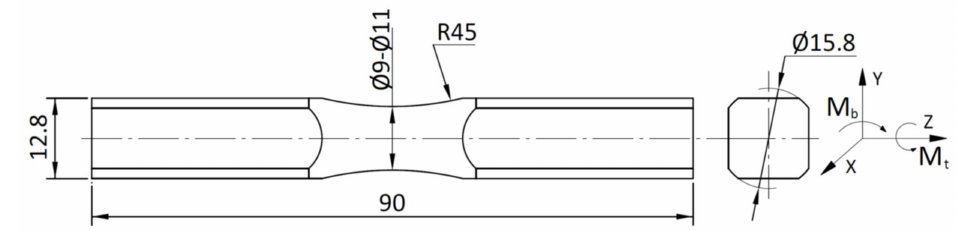
Figure 1. Geometry of the specimen.